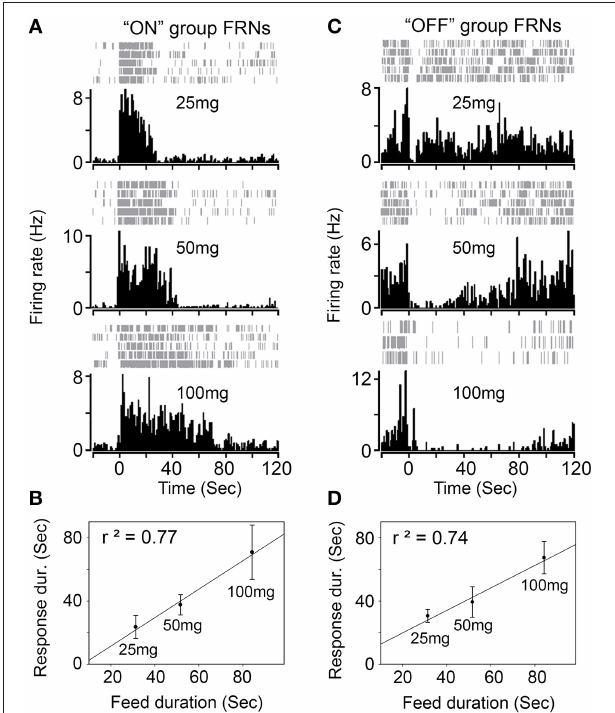
FIGURE 3 | Response of FRNs to the amount of food. (A) One example of “ON” group FRN was tested with three different amount of chew food (25 mg, 50mg and 100 mg). (B) Firing response of “ON” group FRNs correlated with food amount and feed duration ( n = 21 neurons, N = 8 mice). (C) One example of “OFF” group FRN was tested with three different amount of chew food (25, 50, and 100 mg). (D) Firing response of “OFF” group FRNs correlated with food amount and feed duration ( n = 17 neurons, N = 8